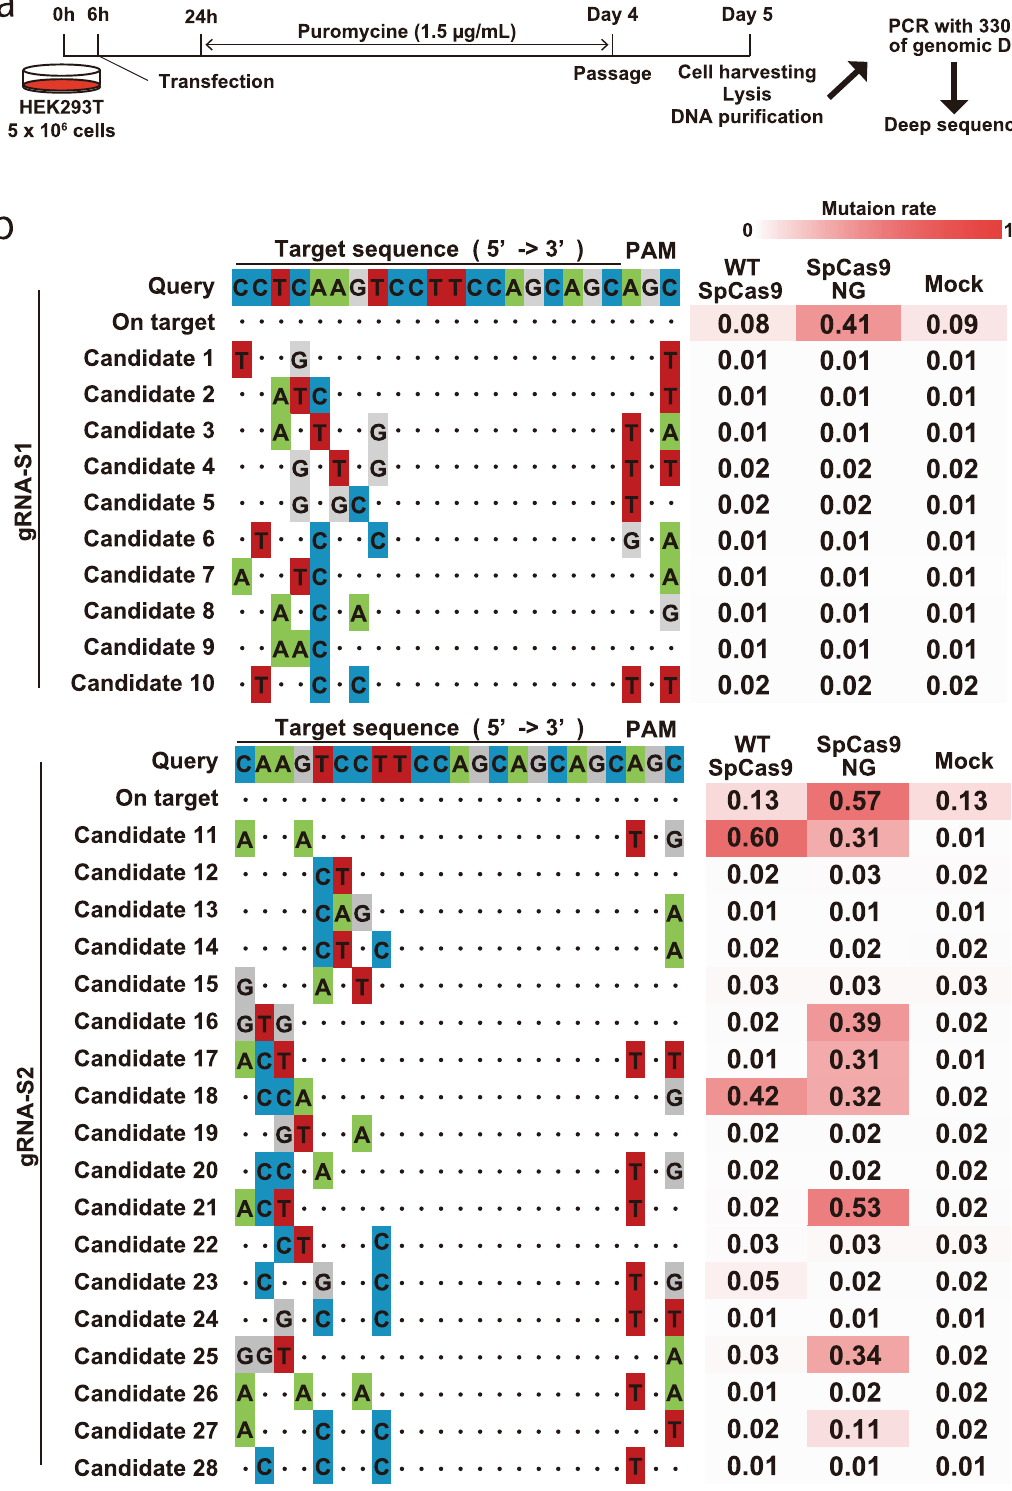
Fig. 3 Off-target analysis of HTT -targeting gRNA. a The procedure of off-target analysis in HEK293T cells. 330 ng of genomic DNA corresponding to 5.0 × 10 4 cells. b Off-target candidate sites and their mutation rate. The mutation rate was calculated by the following formula: [(total reads − no variants)/total reads]. For the on-target site, reads with in-frame 16 – 19 CAG repeats were summed up as no variants.